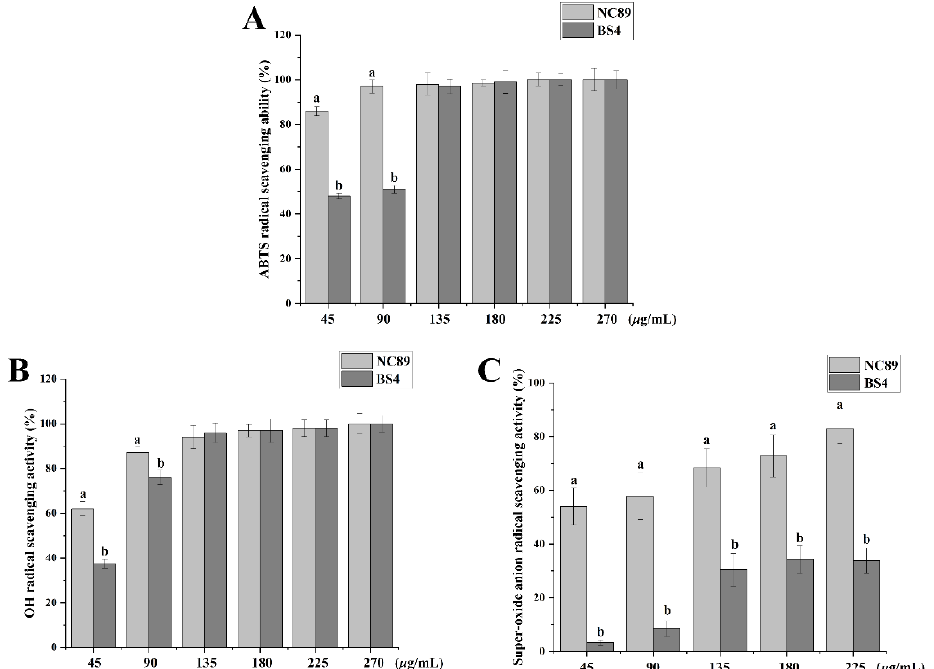
Figure 2. The antioxidant activity of NC89 and BS4 tobacco seed oils. ( A ). ABTS radical scavenging ability, ( B ). OH- radical scavenging activity, ( C ). super-oxide anion radical scavenging activity. Values are presented as the mean ± SD ( n = 3). The different samll letters above bars present significance of difference ( p < 0.05).